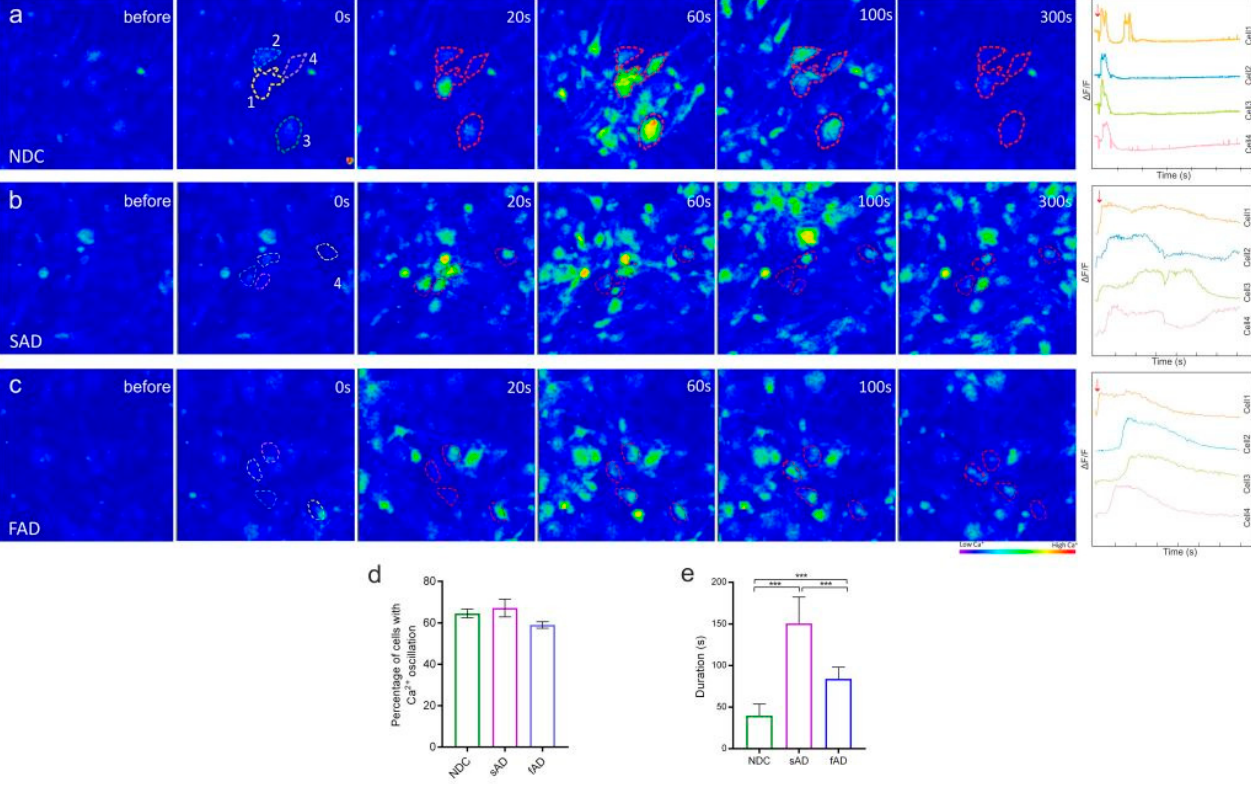
Figure 2. AD-derived astrocytes show increased response to glutamate stimulation in vitro. Rep- resentative field images of glutamate stimulated astrocytes from ( a ) NDC, ( b ) sAD, and ( c ) fAD. Representative images from calcium recordings of four individual cells (location of selected cells marked and numbered in respective fields). Changes in fluorescence intensity were measured using CALIMA software and indicated as ratio measured fluorescence intensity (F) to measured average baseline fluorescence intensity (F/F0) at time (s). Arrow indicates point of glutamate addition. Note the altered stimulation in astrocytes from sAD and fAD when compared to astrocytes from NDCs. ( d ) Graph showing percentage of calcium-positive cells post stimulation. ( e ) Graphs showing dura- tion of calcium transients between the groups post glutamate stimulation. One-way ANOVA followed by Tukey’s multiple comparisons tests, n = 3/group; n = 3 experimental repeats, and *** p < 0.001. 3.2. Tau Protein Induces Morphological Changes Associated with GFAP Upregulation Only